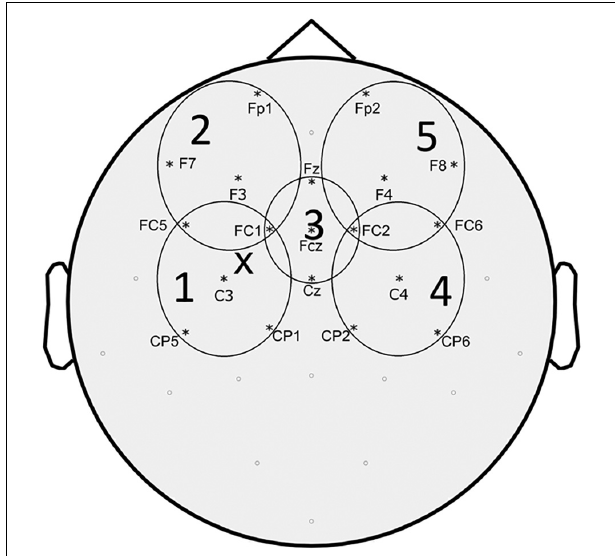
FIGURE 1 | Topographic representation of the EEG electrodes included in each region of interest (ROI) considered for TEPs analysis. “X” represents approximate site of